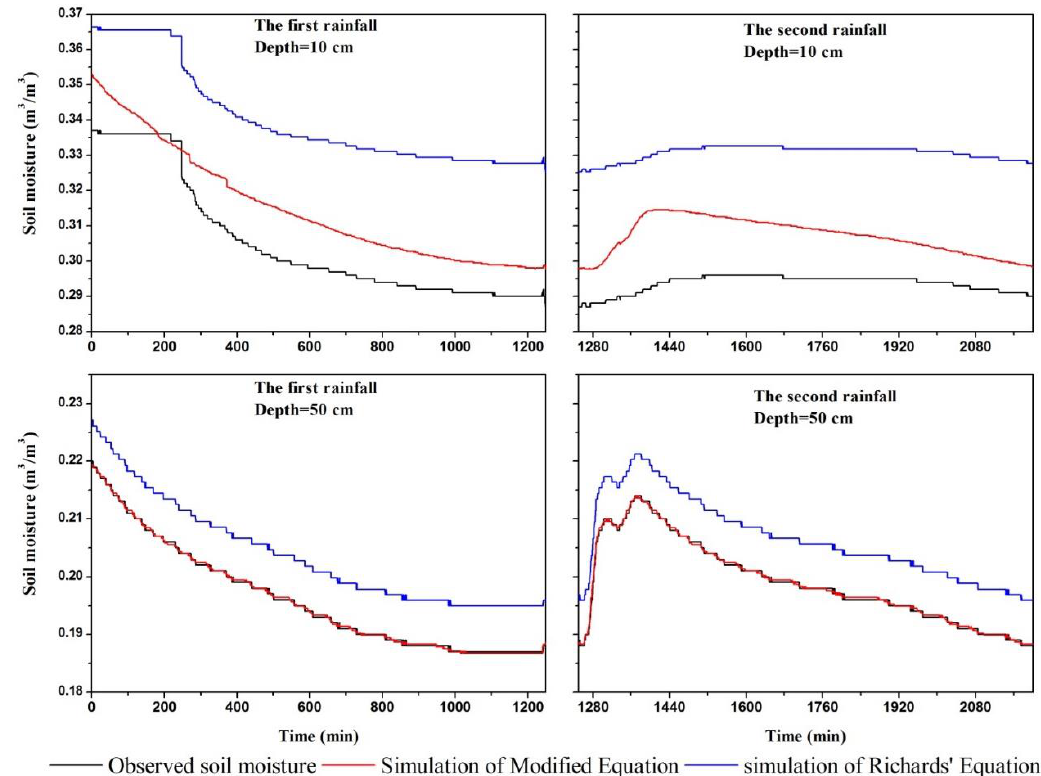
Figure 5. Comparisons of the simulation results among different slope position. The depth is from 10 to 50 cm.